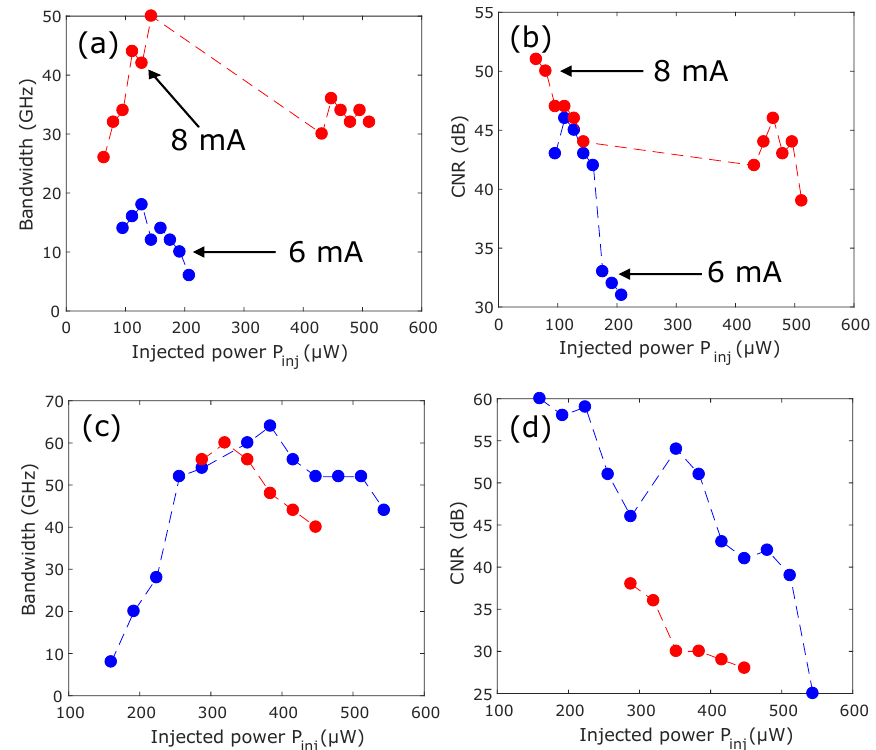
Figure 8. Control of comb properties using the injection parameters and polarization of the injected light. ( a , b ) are obtained for fixed detuning and comb spacing ∆ ν = 1.6 GHz and Ω = 2 GHz, respectively. ( c , d ) are obtained for fixed comb spacing ( Ω = 4 GHz) and injection current I = 8